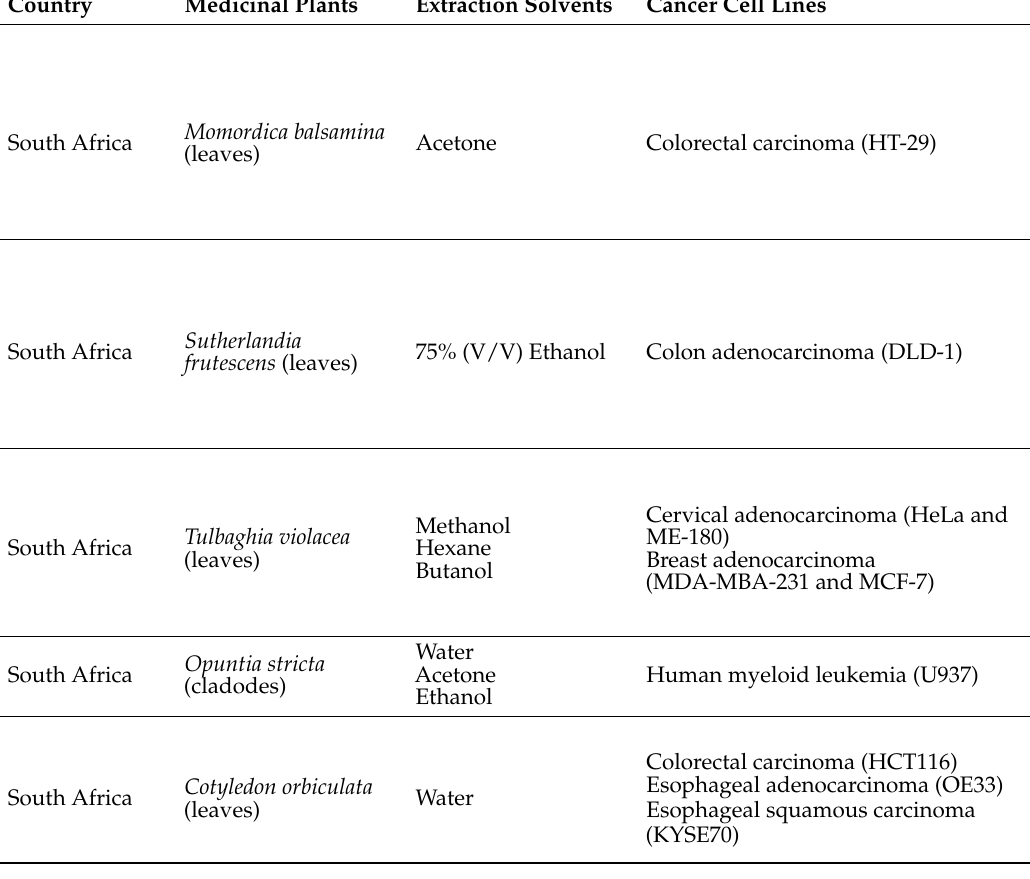
− Viability of HT-29 cells decreased in a concentration- and time-dependent manner. At concentrations > 50 µ g/mL, a significant decrease in cell viability was seen ( p ≤ 0.01).